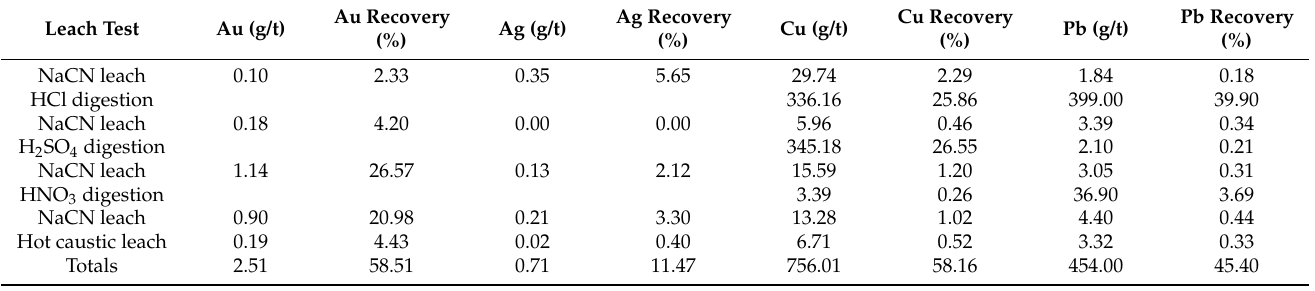
Table 6. Comparison of gold recovery after each pretreatment stage.